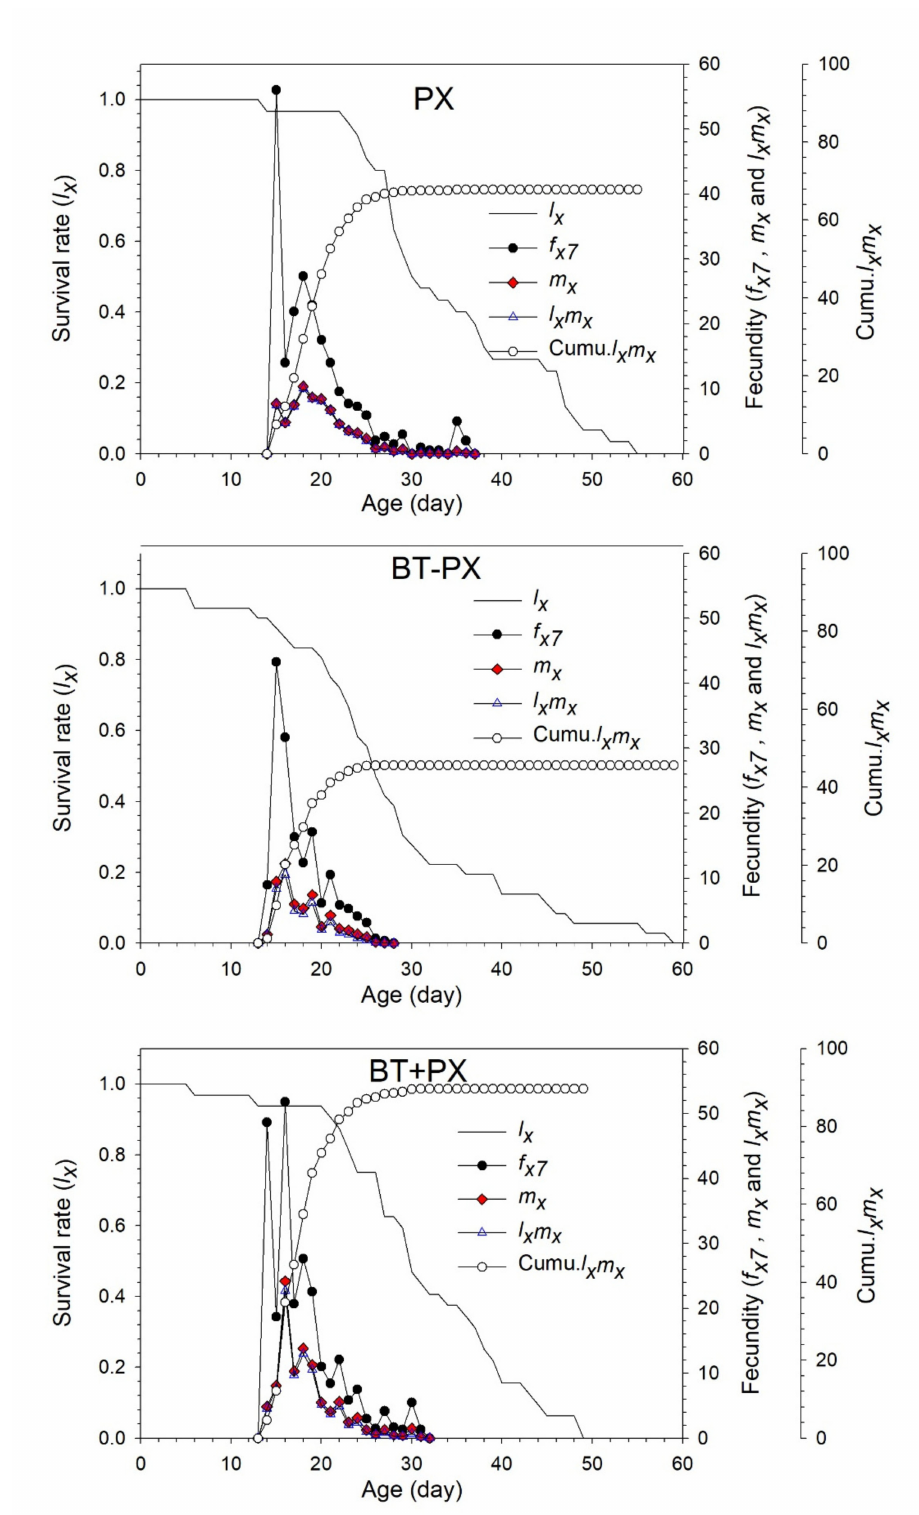
Figure 6. Age-specific survival rate ( l x ), female age-stage specific fecundities ( f x ), fecundity ( m x ) and net maternity ( l x m x ) of Plutella xylostella when feeding on Chinese kale alone (PX), with prior Bemisia tabaci damage (BT − PX) or with simultaneous B. tabaci damage (BT + PX). The age-stage specific reproductive values ( v xj ) of DBM indicated the contribution of an individual at age x and stage j to the future population (Figure 7). The